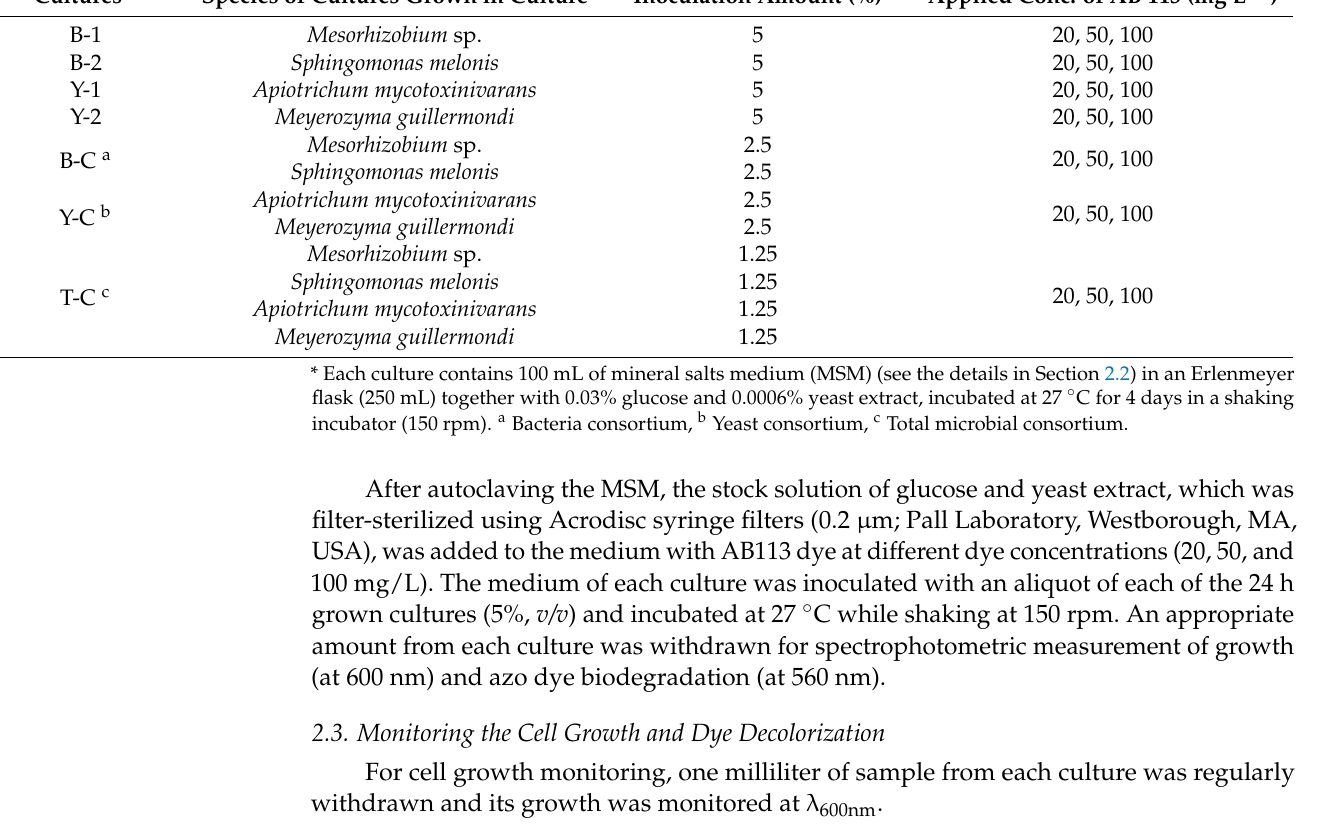
Table 2. Experimental setup of microbial cultures for the biodegradation of azo dye Acid Blue 113. Cultures * Species of Cultures Grown in Culture Inoculation Amount (%) Applied Conc. of AB 113 (mg L − 1 ) 5 20, 50,